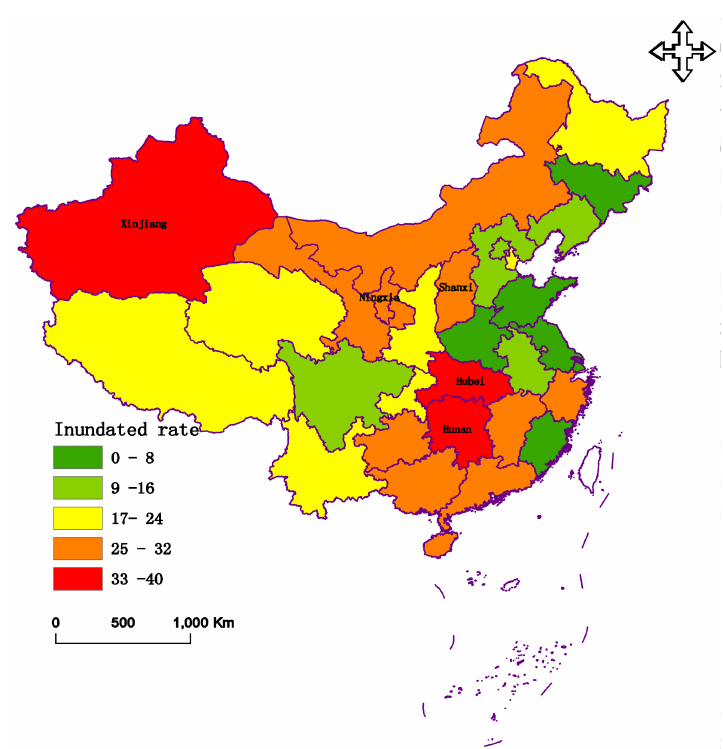
Figure 4. The data of the inundated rate ( C 2) in